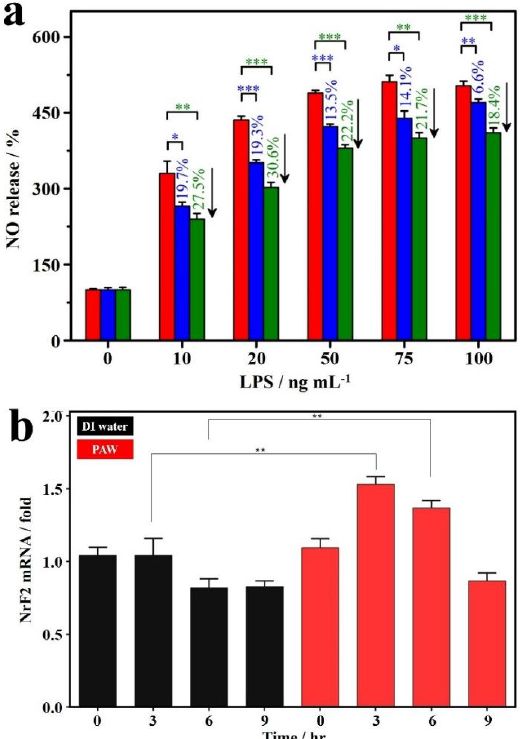
Figure 5. Antioxidative activities of PAW based on cellular experiments. ( a ) Antioxidative activity of AuNT water (also called PAW, blue block) and sAuNT water (also called PAW, green block) compared to DI water (red block) on reduction of lipopolysaccharide (LPS)-induced NO release with dose of LPS. DI water, AuNT water and sAuNT water were used for medium preparation. * p < 0.05; ** p < 0.01; *** p < 0.001. ( b ) Induction of Nrf2 expression in human gingival fibroblasts (HGFs) exposed to PAW. HGFs were incubated in culture medium prepared with DI water or PAW for 0, 3, 6, and 9 h. Nrf2 mRNA expression levels were quantified by a real-time PCR, and results are presented as the relative normalized expression with GAPDH . Data were analyzed by Student’s t -test, and results are presented as the mean ± SD. ** p < 0.01. The corresponding p values are 0.00521 and 0.00453 for 3 and 6 h, respectively [67,77].